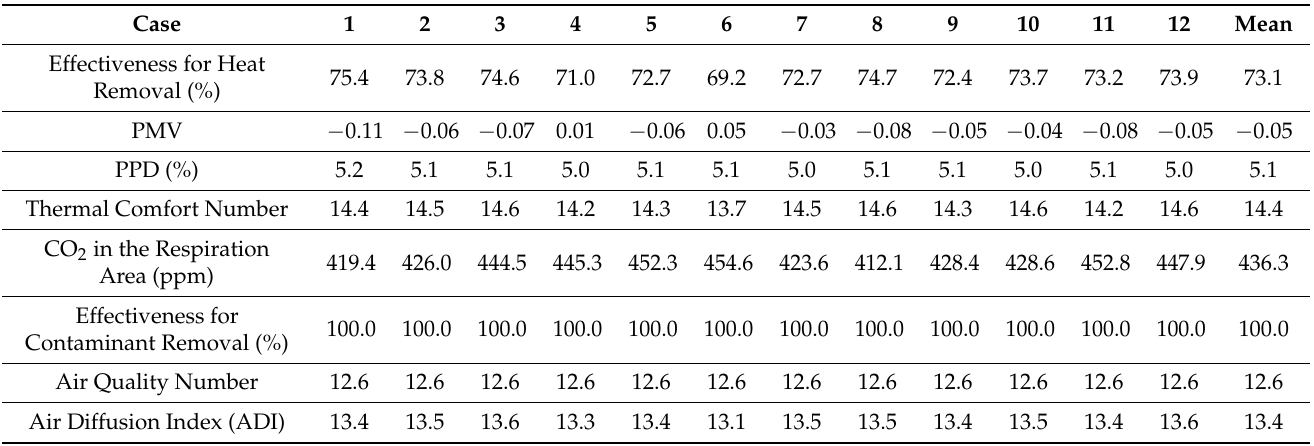
Table 14. ADI obtained for Case V (0.2333m 3 /s) at 16